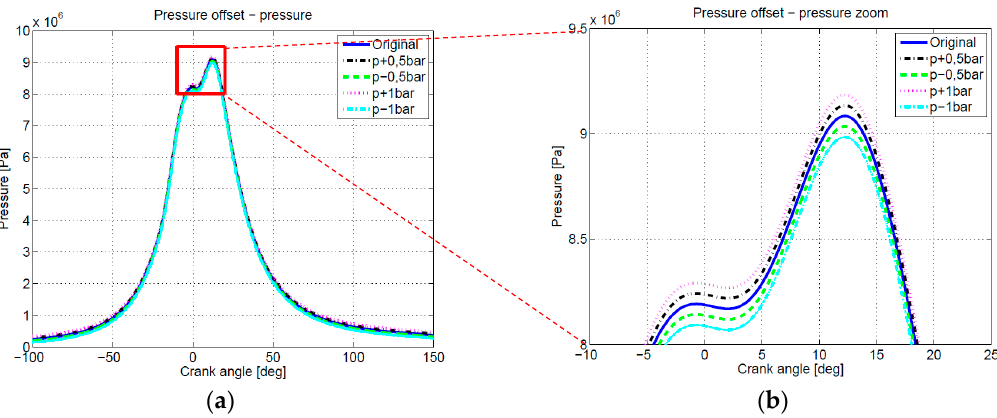
Figure 3. ( a ) Pressure offset variations (±0.5, 1 bar) depending on the crank angle at 2000 1/min and 100 Nm; ( b ) detailed view.